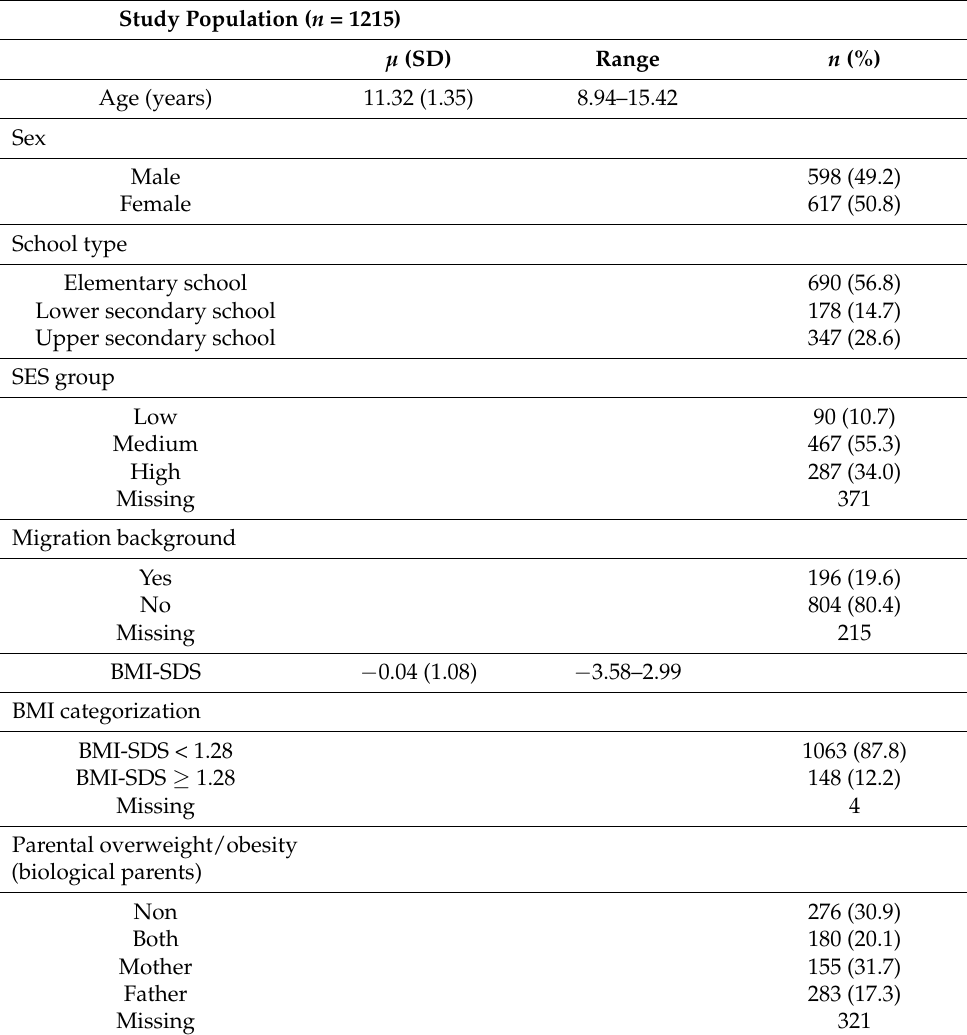
Table 1. Description of the study